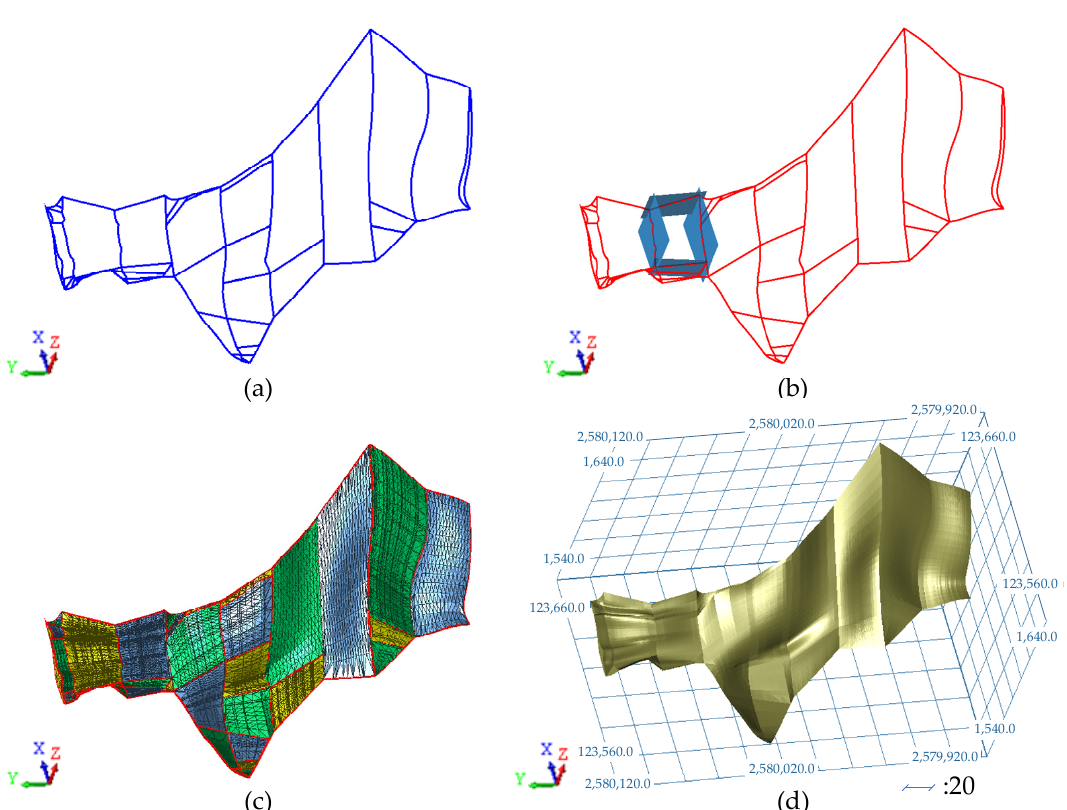
Figure 12. Experimental results of the first set of contour polylines: ( a ) the original contour polylines; ( b ) closed-loop division; ( c ) single closed-loop modeling; ( d ) sub-mesh combination.